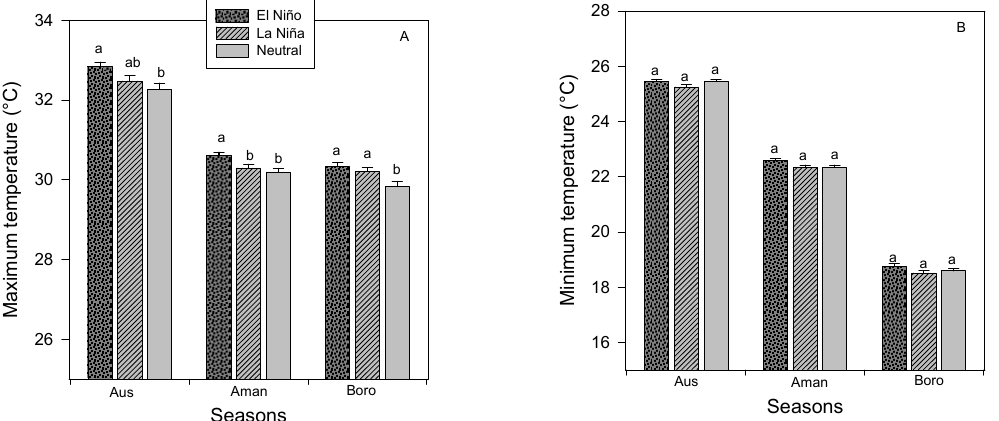
Figure 4. Impacts of ENSO on maximum temperature ( A ) and minimum temperature ( B ) composite during Aus, Aman, and Boro seasons for all selected stations in coastal Bangladesh. Means that do not share same letters are statistically significant (Tukey’s b, α = 5%). The error bars represent the standard error of the means.